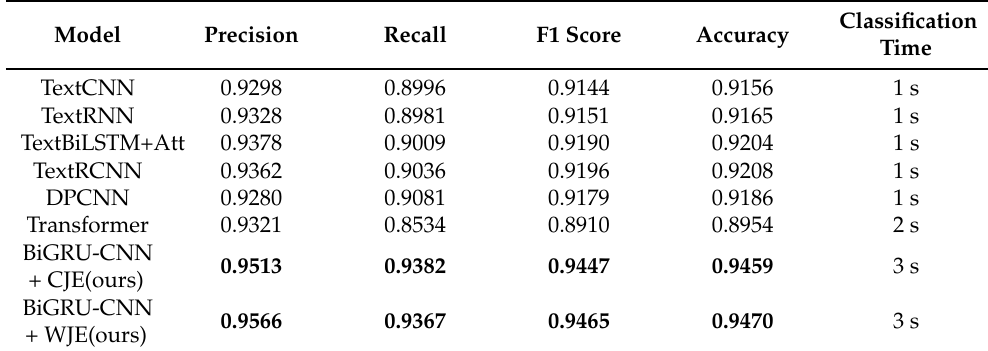
Table 3. Comparison of the Chinese chat spam detection performance of different